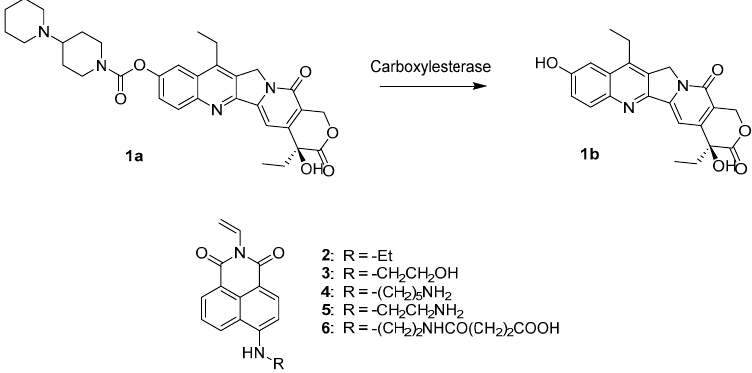
Figure 1. Structures of irinotecan ( a ) SN-38 ( b ) and of the functional monomers 2–6 used in this